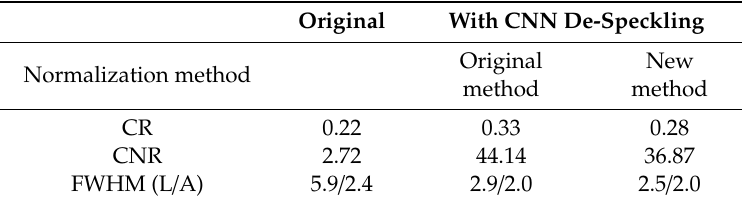
Table 8. Quantitative analysis of di ff erent normalization methods.